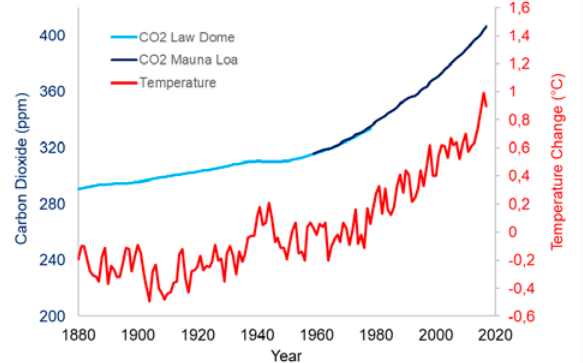
Figure 2. Correlation between the change in the mean annual temperature records and the CO 2 concentration. Temperature data from NASA/GISS; 3 CO 2 concentration data from Mauna Loa, Hawaii, 4 and from ice cores from Law Dome, Antarctica.